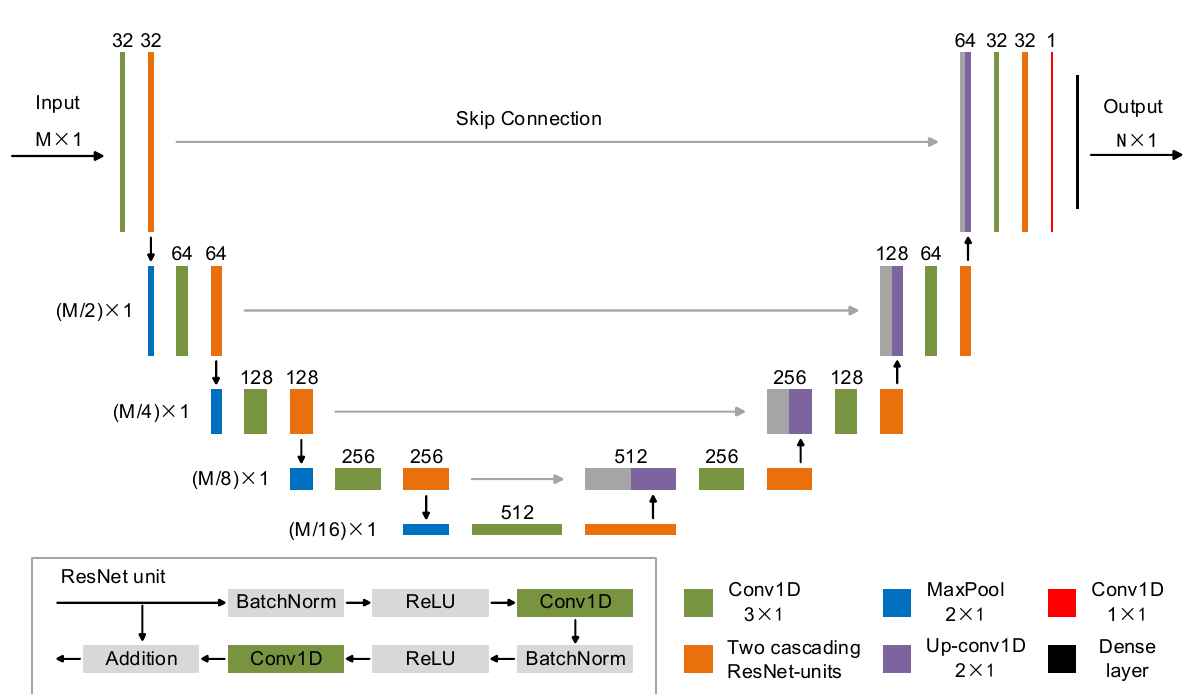
Figure 2. Architecture of the proposed 1DUResNet following Unet-like and ResNet-like 1D CNN design.